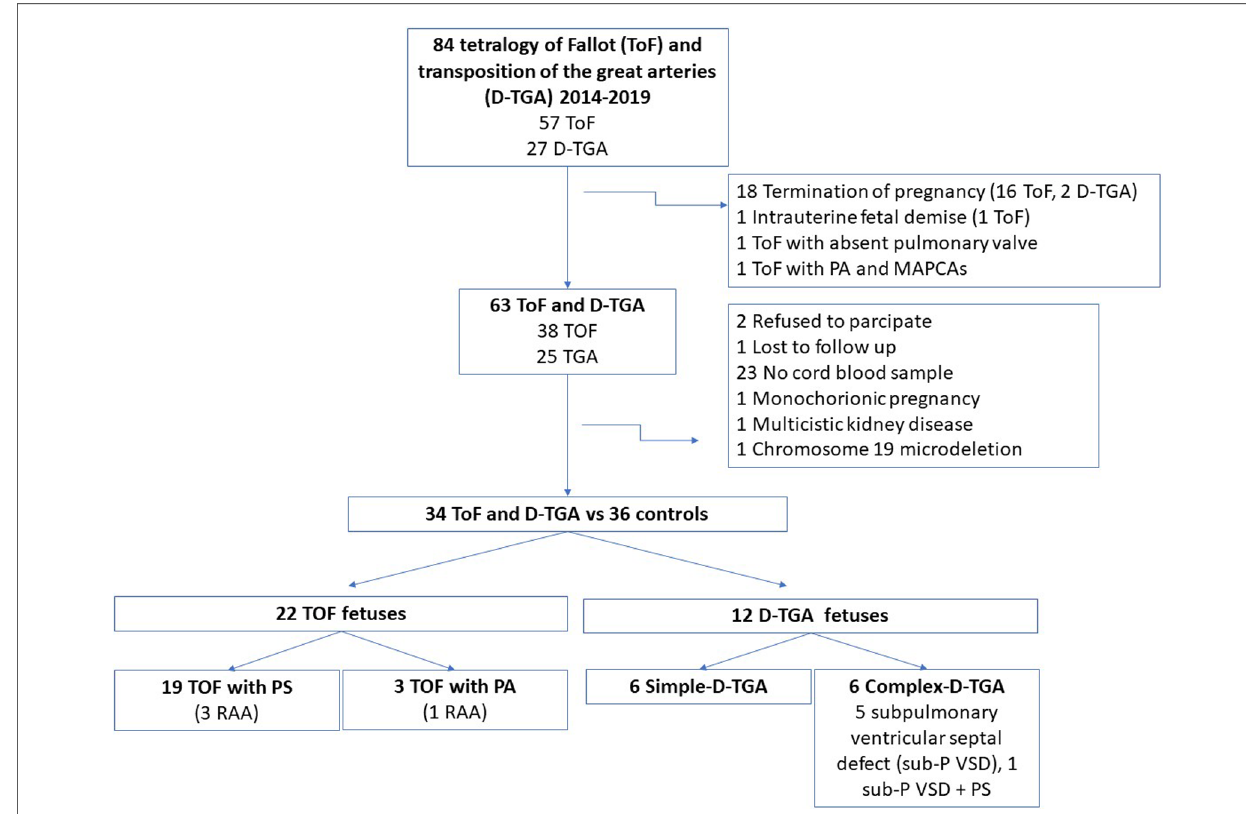
FIGURE 1 Flow chart of fetuses with conotruncal congenital heart defects included in the study. ToF, tetralogy of fallot, D-TGA, transposition of the great arteries; PA, pulmonary atresia; MAPCAs, major aortopulmonary collateral arteries; RAA, right aortic arch; sub-P VSD, subpulmonary ventricular septal defect; PS, pulmonary